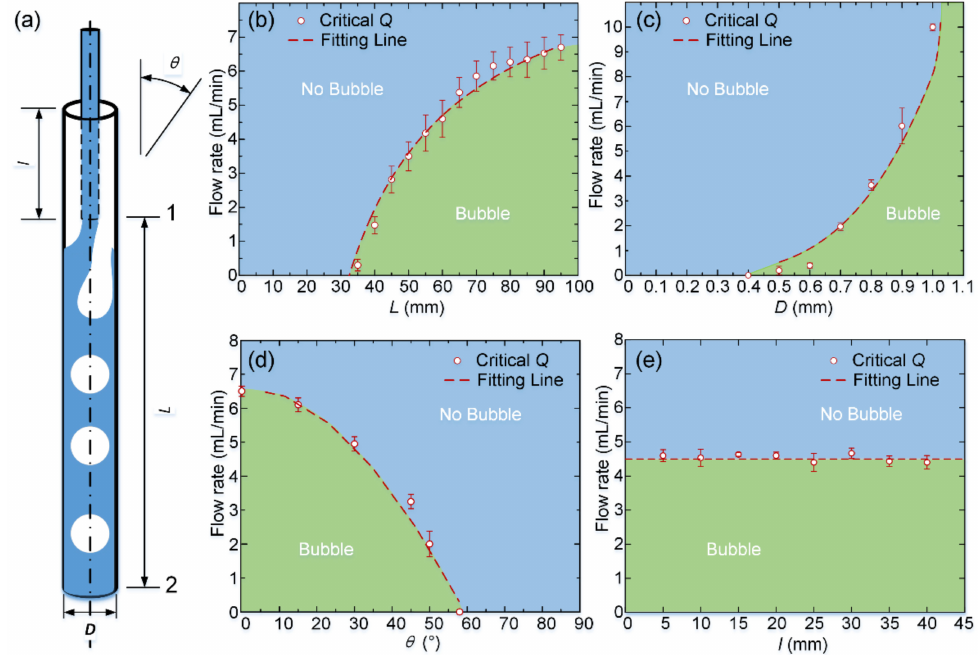
Figure 3. ( a ) Schematic diagram of the SPFM device. The effects of geometry parameters of the SPFM device, θ , L , D , and l on the bubble formation were systematically evaluated; ( b – d ) the phase diagram of bubble formation phenomena. The blue zone corresponds to the regime with no bubble formation in the device, while the green zone means microbubbles can be prepared under these parameter combinations. The dashed line is the theoretically fitted curve, and the red circles represent the critical flow rate for bubble formation while changing the geometry parameters: ( b ) L , ( c ) D , ( d ) θ , and ( e ) l